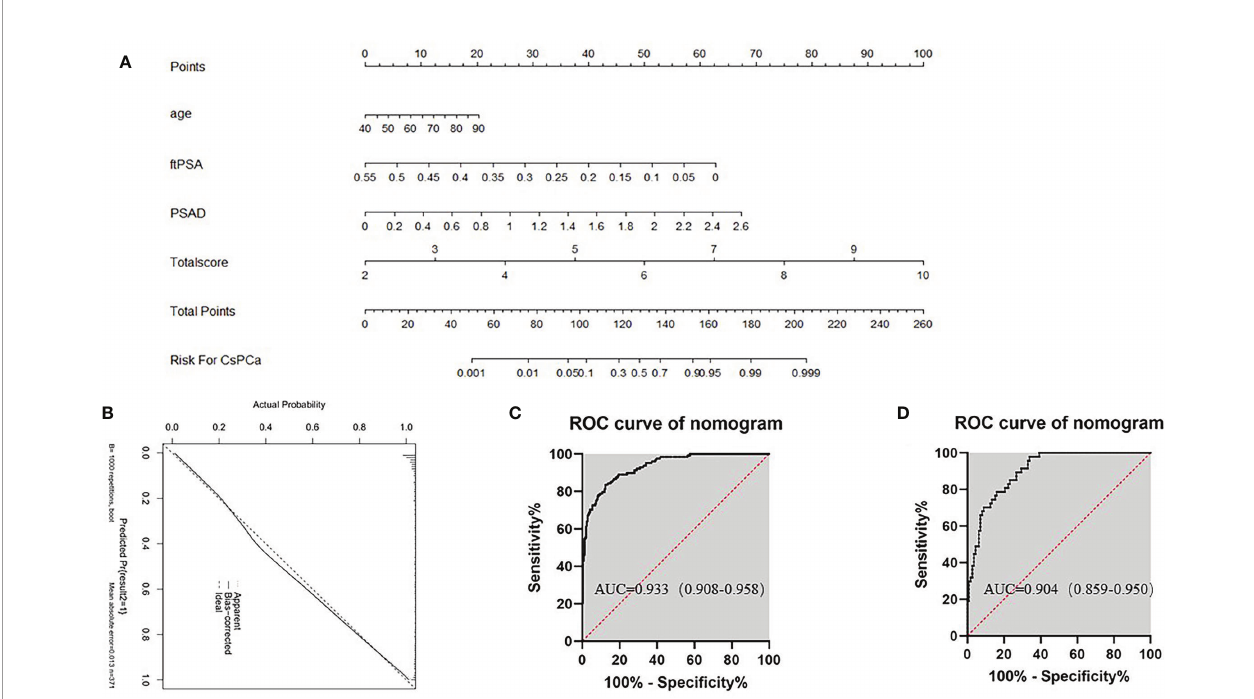
FIGURE 4 | Nomogram predicts the probability of csPCa. Established a Nomogram based on bpMRI and other clinical indicators. (A) Nomogram for diagnosis of clinically signi fi cant cancer (csPCa). Higher total points indicated a higher prevalence for csPCa. (B) Nomogram-predicted probability of csPCa. (C) The AUC of Nomogram-predicted probability of csPCa in the training group. (D) The AUC of Nomogram-predicted probability of csPCa in the validation